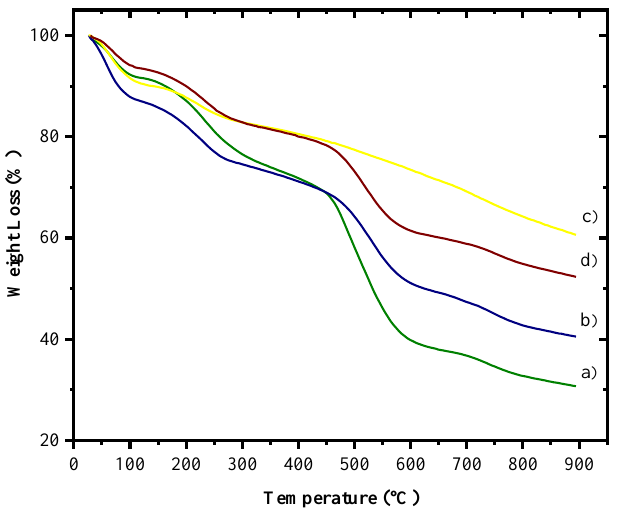
Figure 9. TGA curves of ( a ) PANI (olive green) and nanocomposites of ( b ) SiO 2 -PANI (blue), ( c ) CeO 2 -PANI (yellow), and ( d ) TiO 2 A-PANI (burgundy).